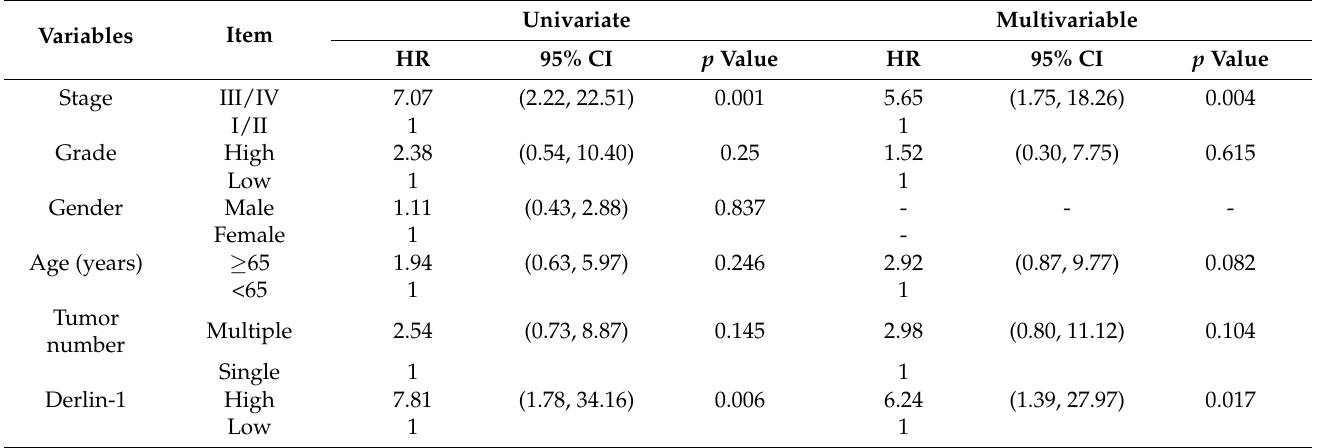
Table 4. Analysis of cancer-specific survival for